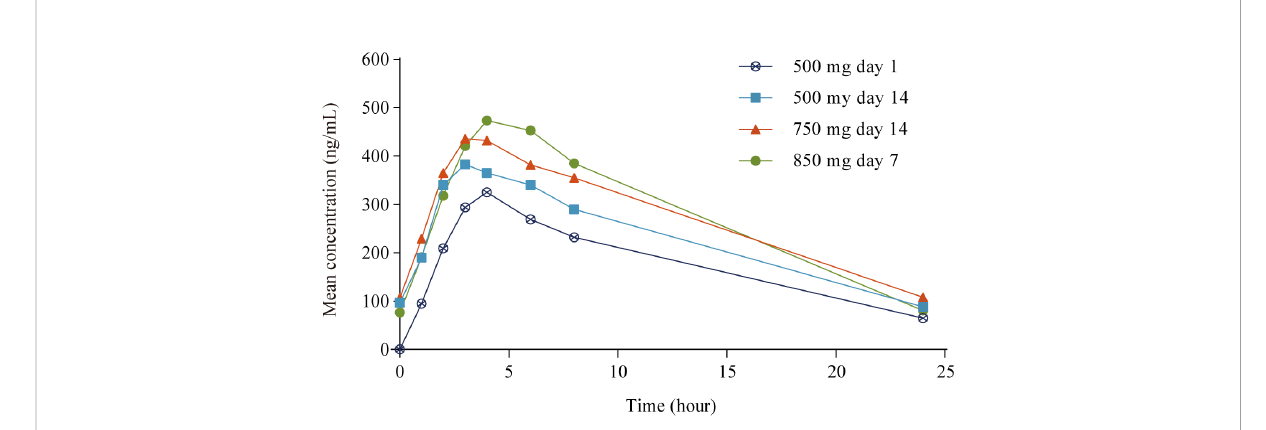
FIGURE 1 Mean plasma concentration-time pro fi le in pharmacokinetic analysis set.